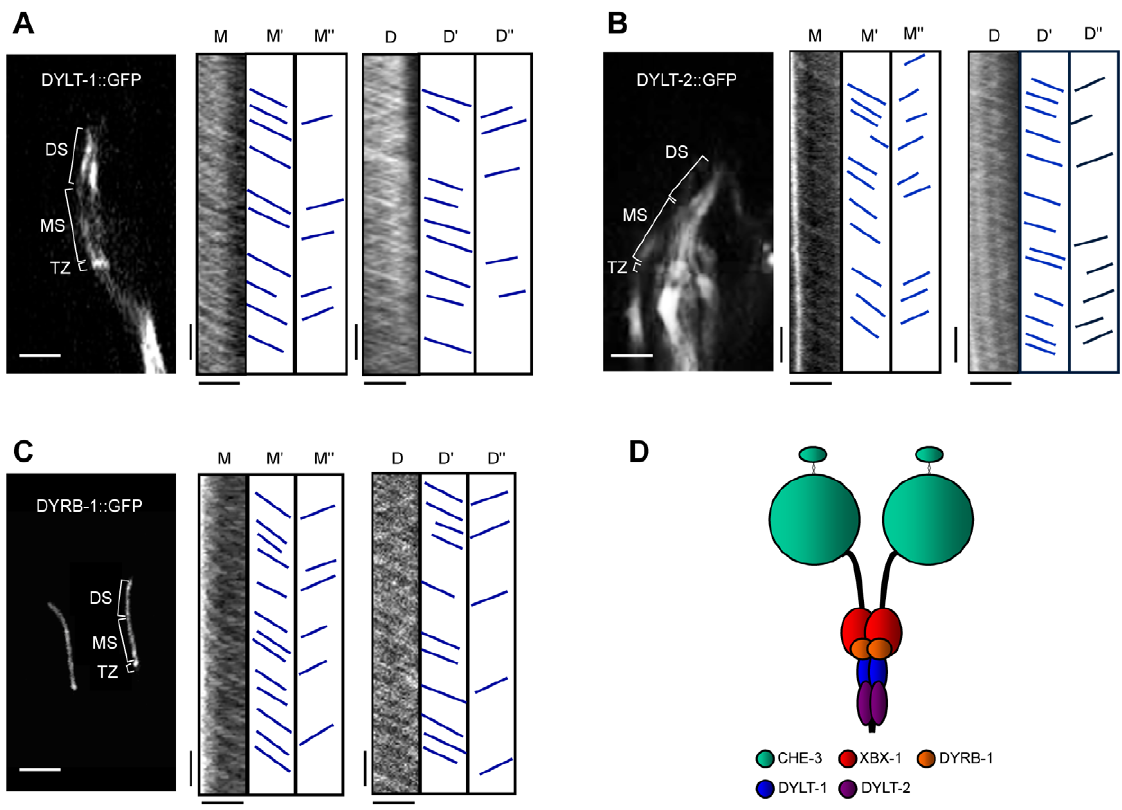
Figure 2. Three dynein light chains undergoing IFT indicate that they are components of the IFT-dynein complex. (A–C) IFT assays of three dynein light chains. The fluorescent micrographs of specific localization of DYLT-1::GFP in cilia of the ADF neuron (A), DYLT-2::GFP in cilia of amphid neurons (B) and DYRB-1::GFP in cilia of phasmid neurons (C) are shown in the left panels. Transition zones (TZ), middle (MS) and distal (DS) segments are indicated. Kymographs with corresponding cartoons indicate trajectories of moving particles along middle (M) and distal (D) segments in both anterograde (M’, D’) and retrograde (M’’, D’’) directions are shown in the middle and right panels. The horizontal bars represent 2.5 m m and the vertical bars represent 5 s. (D) A hypothetical model of the conventional IFT-dynein complex organization in C. elegans . The IFT-dynein complex in C. elegans consists of essential components, heavy chains (CHE-3) and light intermediate chains (XBX-1). The accessory components, Tctex 1-type dynein light chains such as DYLT-1 and DYLT-2, and a Roadblock-type light chain, DYRB-1, are non-essential and specifically associated with IFT-